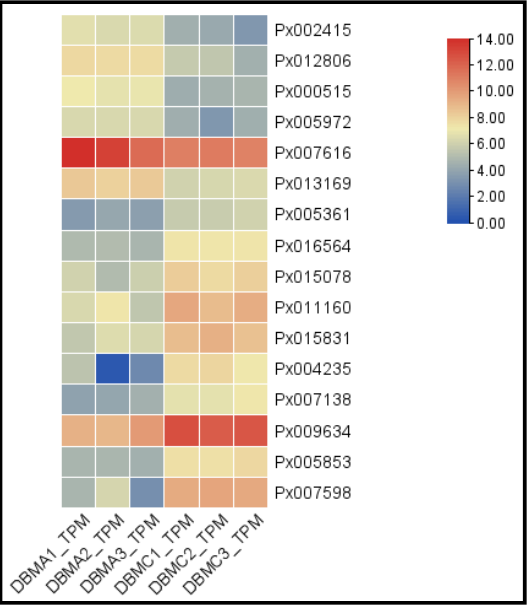
Figure 6. Heat maps of 16 genes with significant expression differences between the G88 and Cry1S1000 strains. DBMA_TPM and DBMC_TPM represent the value of G88 susceptible and Cry1S1000 resistant strains. Cry1S1000 resistant